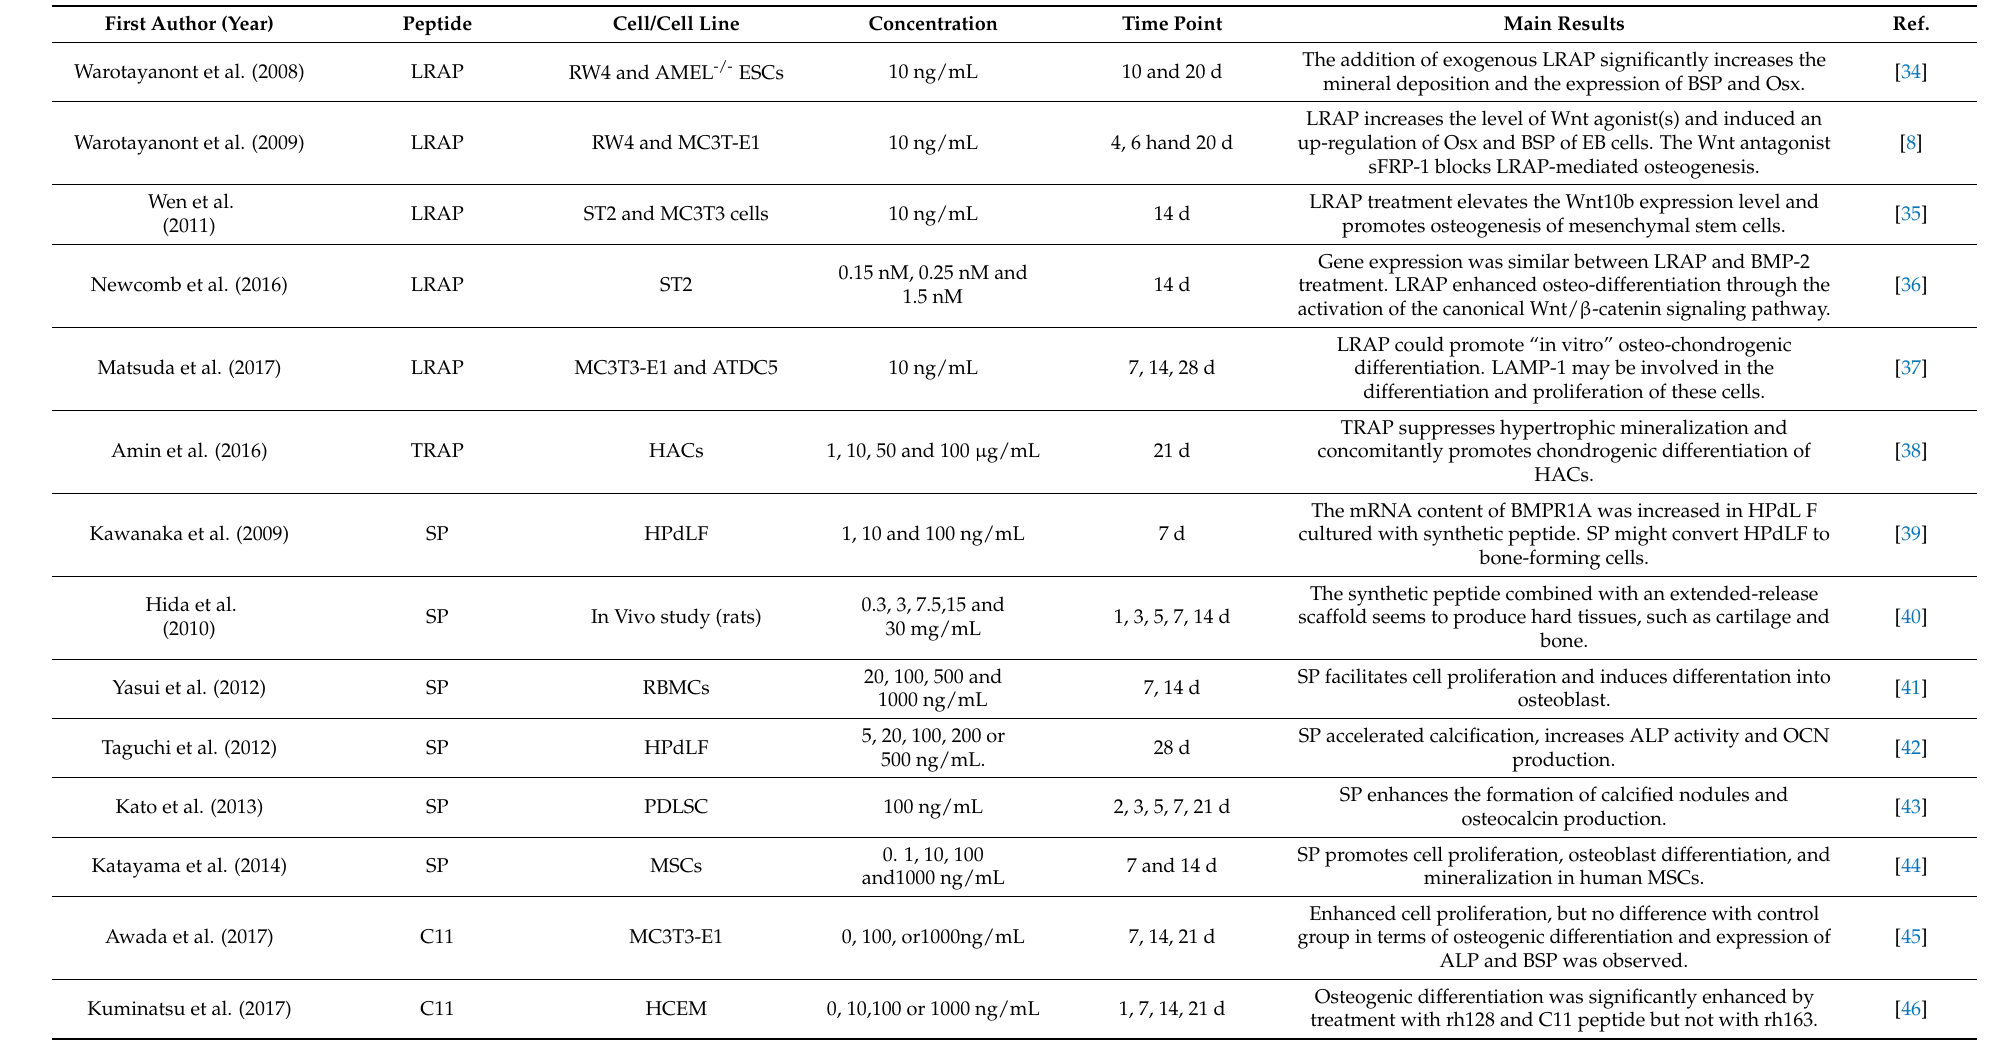
Table 2. Articles dealing with the effect of LRAP, TRAP, SP, and C11 on bone regeneration included in the systematic